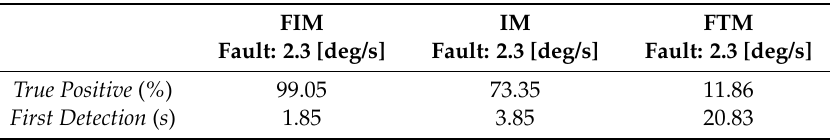
Figure 8. Evolution of the FIM, IM and FTM binary fault indicators for validation flight 1 in case of hard failure on the p ( k ) sensor of amplitude 2.29 deg/s active in a time window of about 3 min indicated by the vertical dashed lines. Table 6. Mean FD performance in the four validation flights for the sensor p